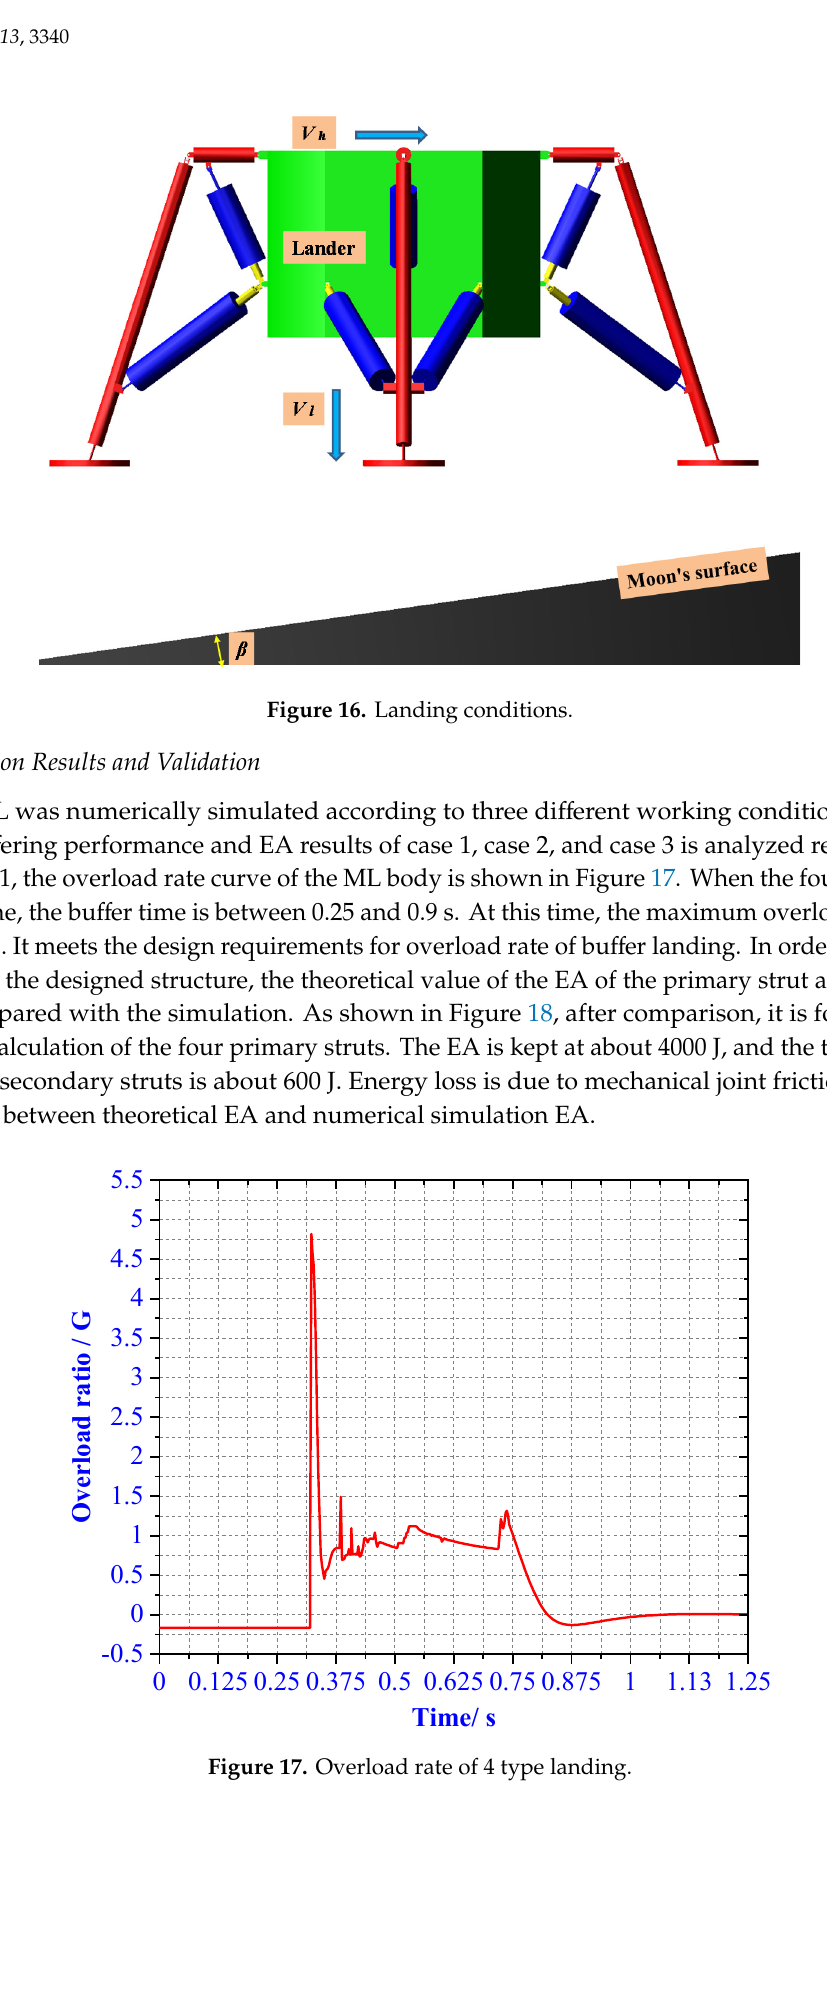
0.3 Table 6. Structure parameter of the ML. Category